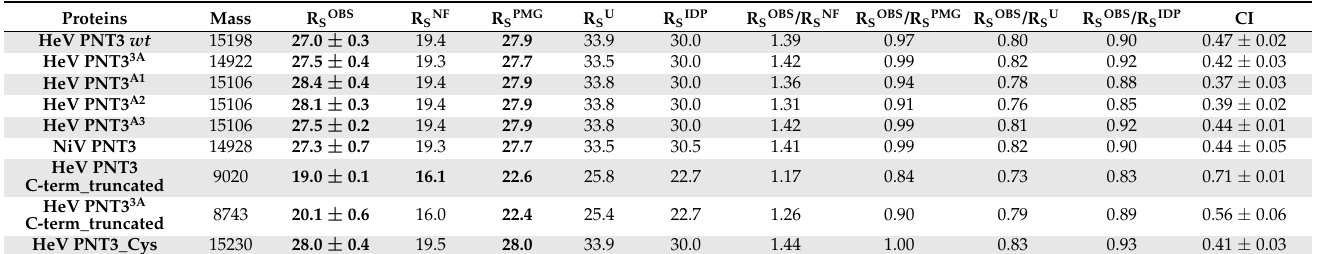
Table 1. Stokes radii (R SOBS , Å) of the PNT3 variants as inferred from the elution volume of the major SEC peak. Shown are also the expected values for the various conformational states, along with the ratios between the R SOBS and each R S state, and compaction index (CI)